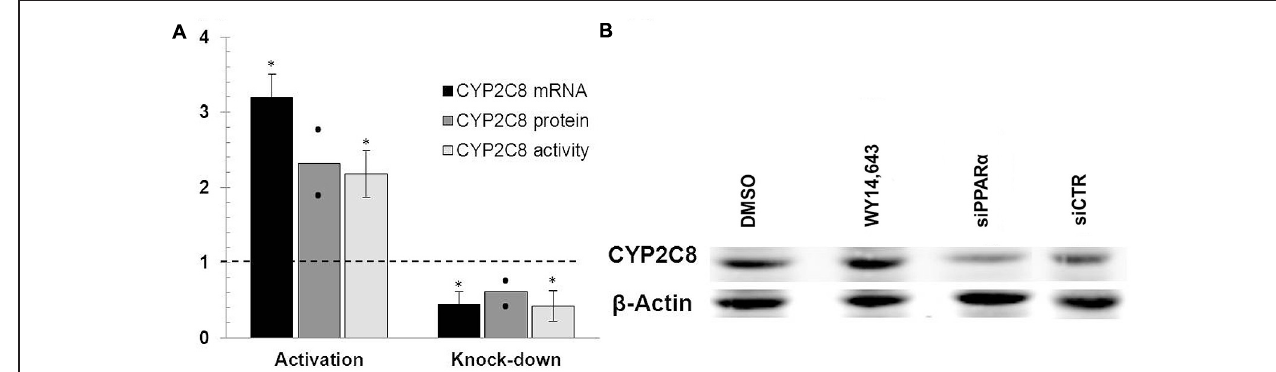
FIGURE 3 | PPAR α knockdown and activation in HepaRG cells. (A) mRNA levels were measured in HepaRG cultures cultured in three independent differentiation batches 72 h after PPAR α activation using ligand WY14,643 (left part of the diagram) or siRNA-mediated PPAR α knock-down (right part of the diagram) and compared with mRNA levels measured in cells treated with either DMSO (left) or non-targeting siRNA (right) set at 1.0. The graph shows the means from three (mRNA, activity) or two (protein) independent experiments, with error bars indicating standard deviations (mRNA, activity) and dots representing individual data points (protein). ∗ , Statistically significant ( P < 0.05, paired t -test). (B) Representative Western Blot analysis of the corresponding protein levels of CYP2C8 following either ligand-mediated induction (lanes DMSO and WY14,643) or siRNA-mediated knock-down (lanes siPPARa and siCTR) of PPAR α .